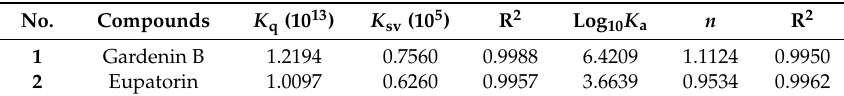
Figure 9. The Stern–Volmer plots for XO fluorescence quenching by ( a ) gardenin B and ( b ) eupatorin at 300.15 K. Table 2. The affinity constants of gardenin B and eupatorin for XO. Abbreviations: K q , K av , R 2 , n , number of binding sites per protein molecule.